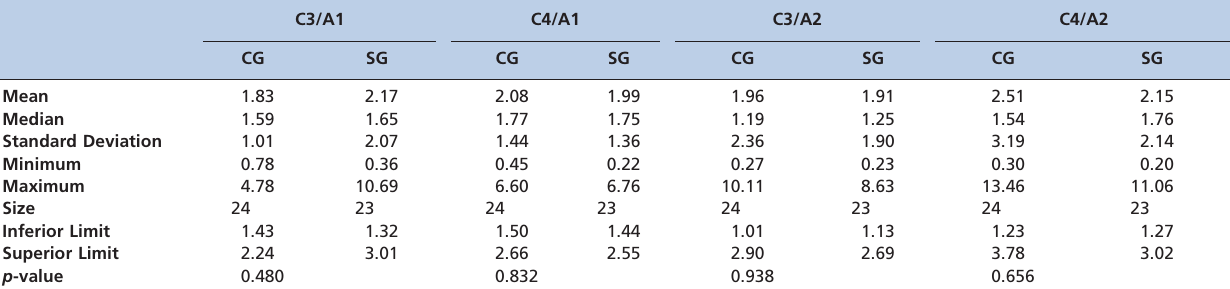
Table 3 - The control (CG) and study (SG) group comparisons regarding the AMLR Na-Pa amplitudes in the C3/A1, C4/A1, C3/A2, and C4/A2 modalities.